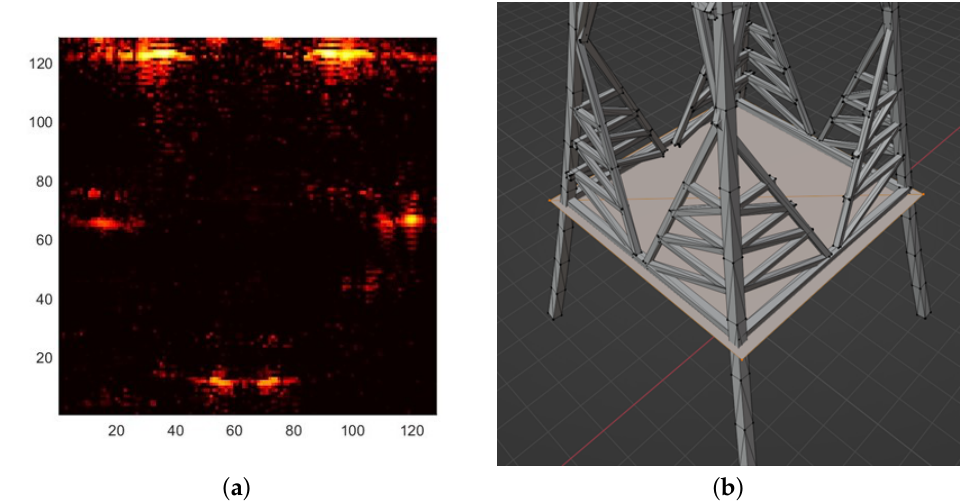
Figure 9. Height slice of electricity pylon at 4.8m. ( a ) Weighted MIRF; ( b ) Detail from CAD model.